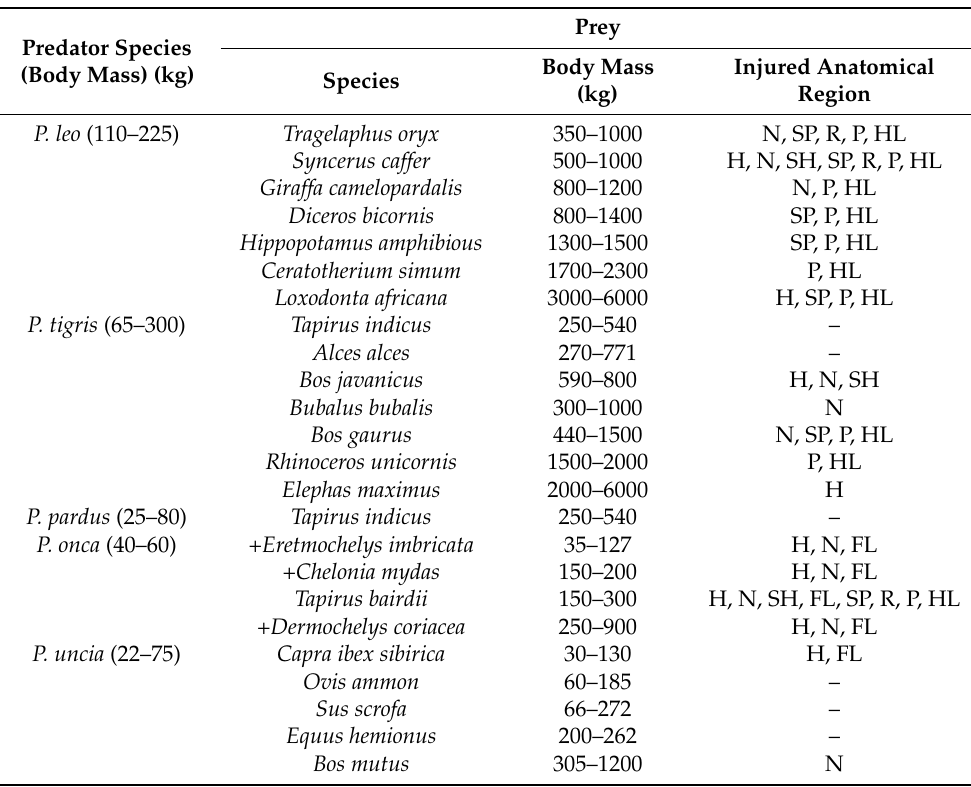
Table 2. Anatomical regions injured in attacks of species of the genus Panthera on prey species larger and heavier than them. H = head, N = neck, SH = shoulder, FL = forelegs, SP = spine, R = ribs, P = pelvis and HL = hindlegs. +Sea turtle species.